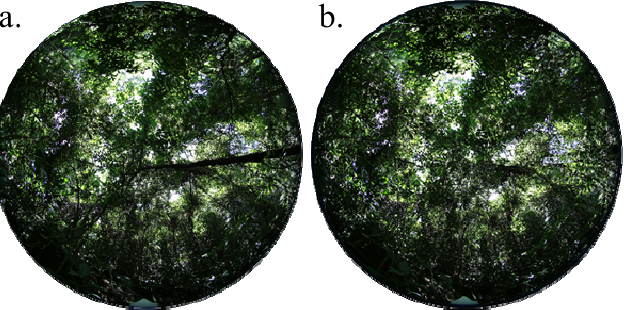
Figure 7. Treatment of woody components based on PS method. ( a ) original image; ( b ) processed image.